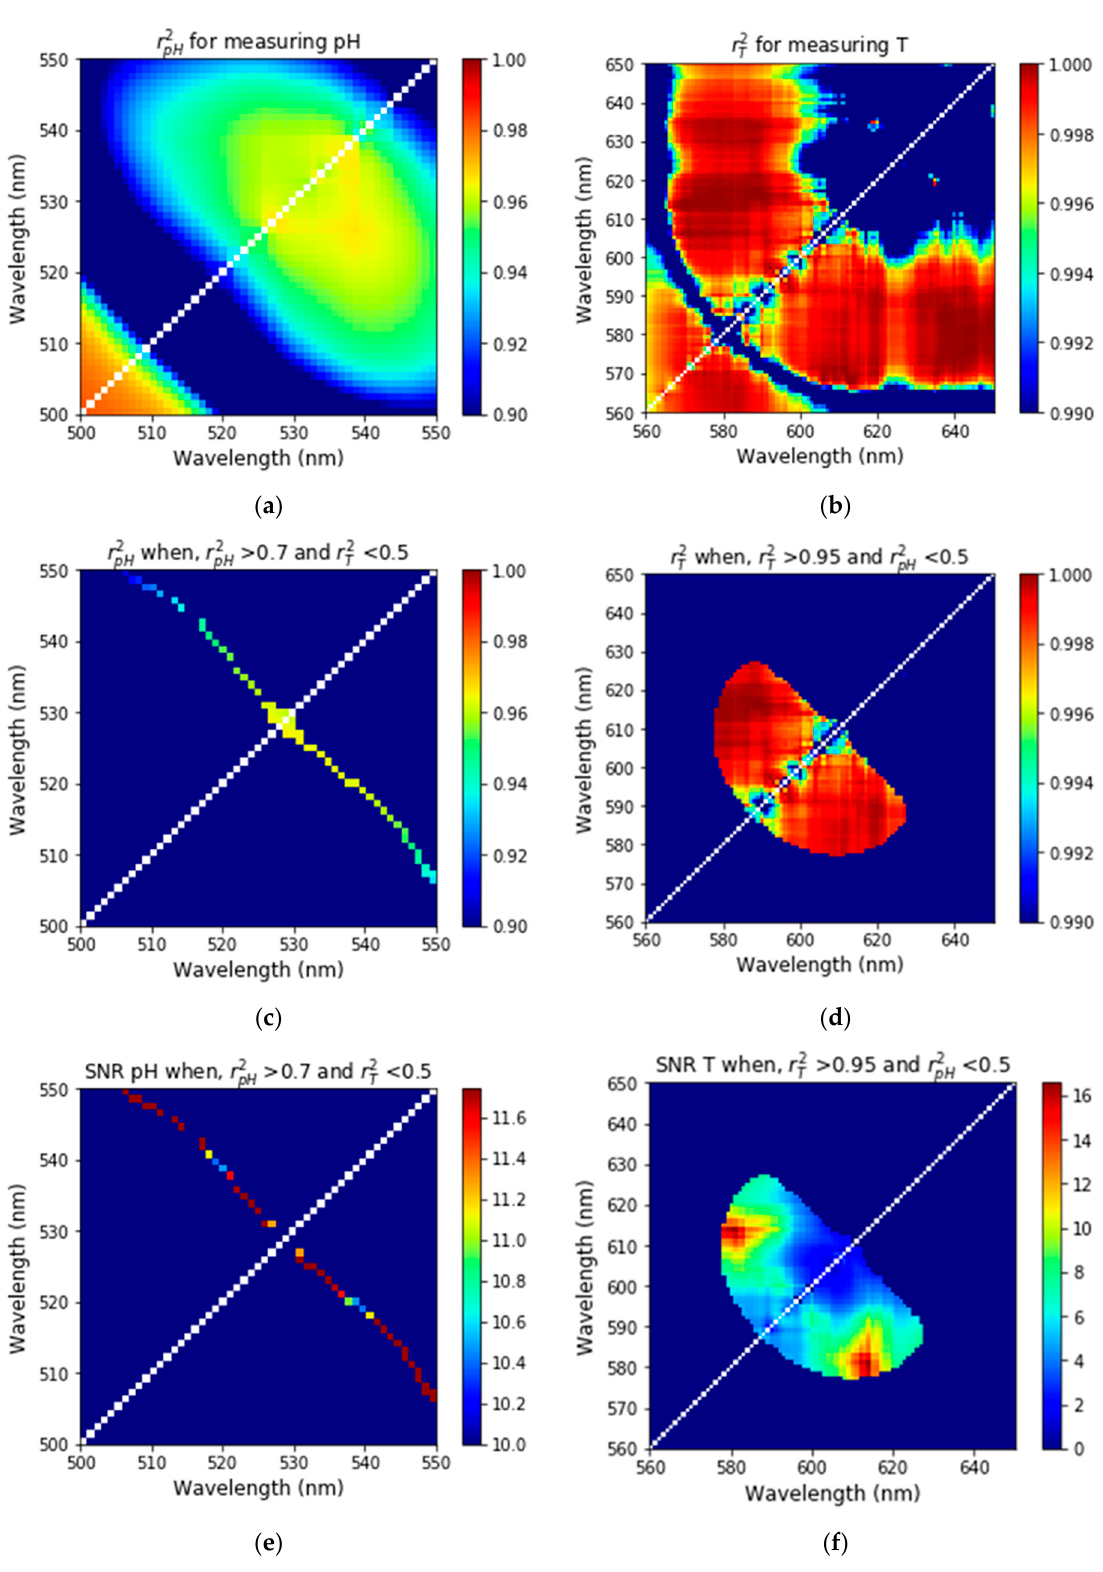
Figure 6. The Pearson correlation coefficient and signal-to-noise ratios for different wavelengths. The Pearson correlation coefficients for pH ( a ) and temperature ( b ) measurements. Pearson correlation coefficient for ( c ) pH when PCC of pH is greater than 0.7 while PCC of temperature is less than 0.5 and for ( d ) T when PCC of temperature is greater than 0.95 while PCC of pH is less than 0.5. SNR for ( e ) pH when PCC of pH is greater than 0.7 while PCC of temperature is less than 0.5 and for ( f ) T when PCC of temperature is greater than 0.95 while PCC of pH is less than